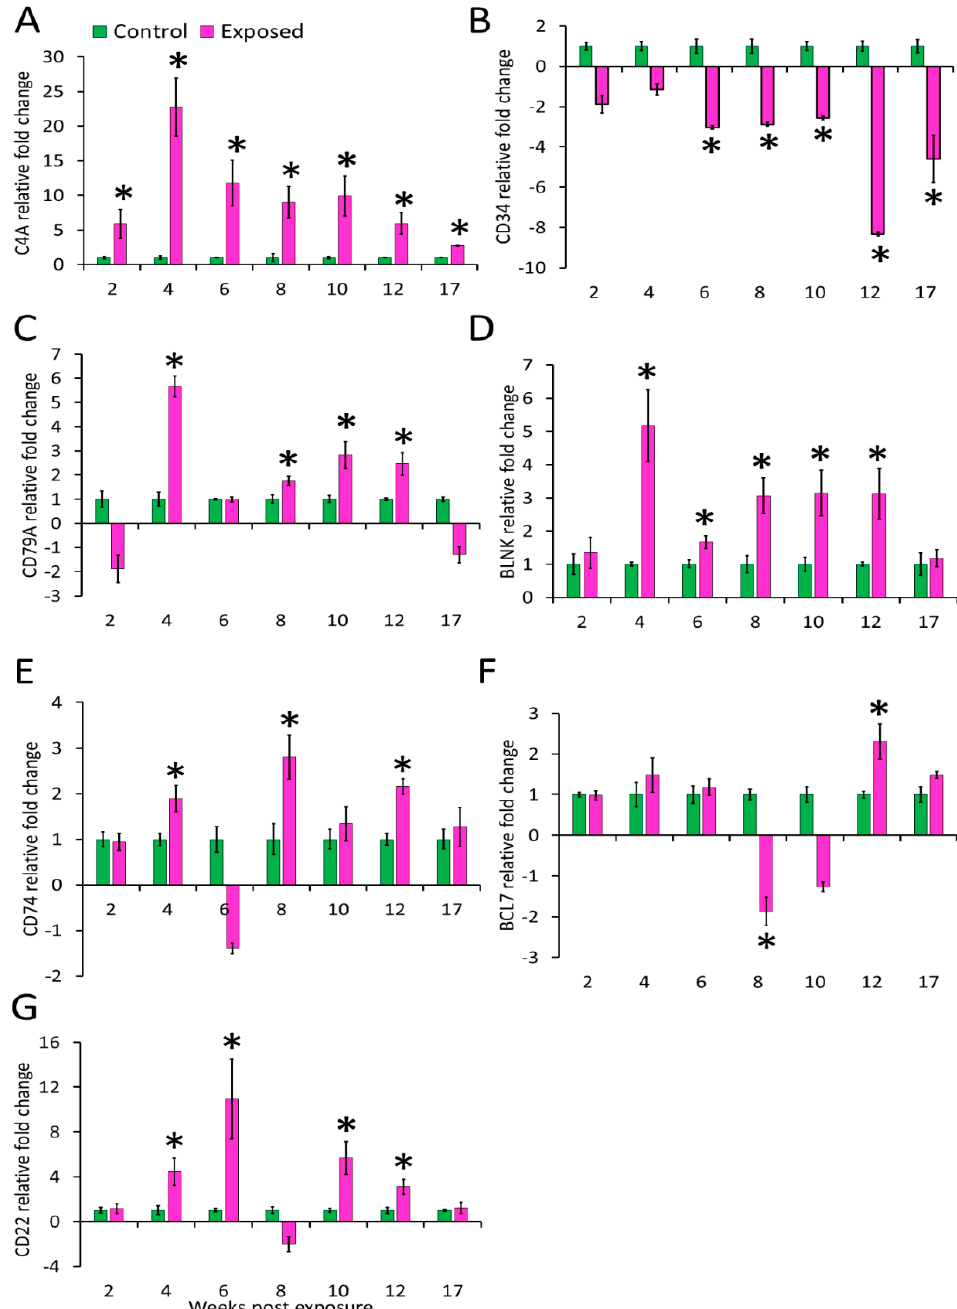
Figure 4. Relative expression of immune genes in kidney. ( A ) C4A; ( B ) CD34; ( C ) CD79A; ( D ) BLNK; ( E ) CD74; ( F ) BCL7; and ( G ) CD22. The relative fold change was first normalised to EF-1 and β -actin, and then represented as a fold change relative to control fish gene expression levels. Asterisks (*) denote the significant difference in relative fold change expression. Each bar shows the mean ± SEM ( n =